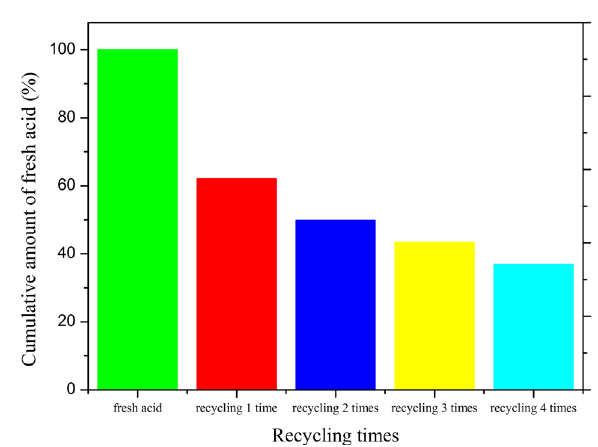
Figure 9: Fresh acid required for acid hydrolysis after a varied number of waste liquid